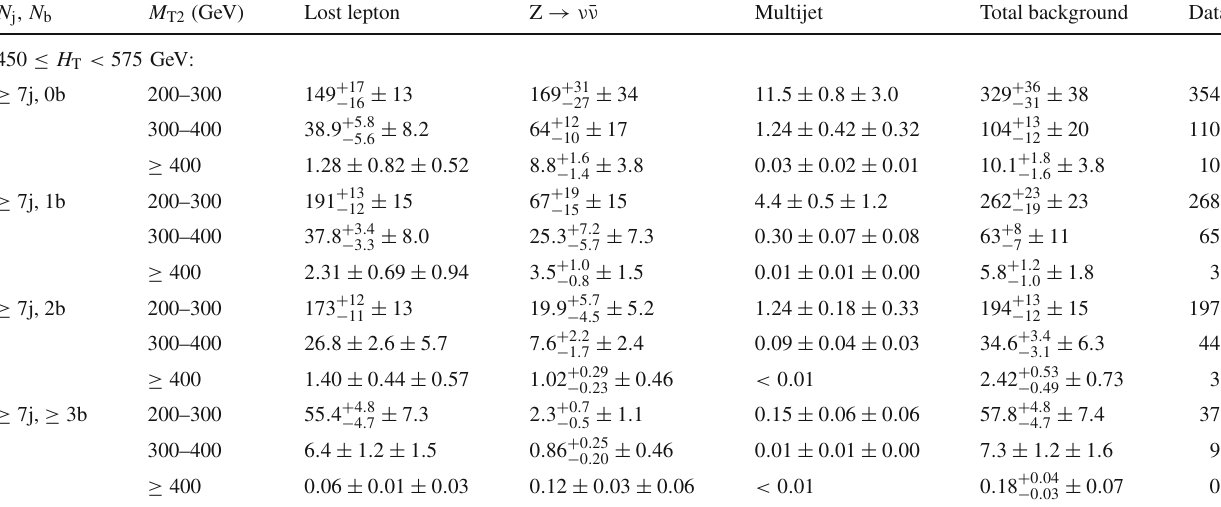
Table 15 Predictions and observations for the 12 search regions with 450 ≤ H T < 575 GeV and N j ≥ 7. For each of the background predictions, the first uncertainty listed is statistical (from the limited size of data control samples and Monte Carlo samples), and the second is